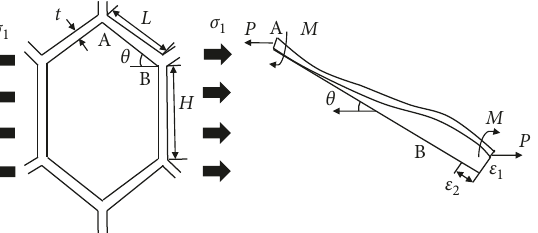
Figure 6: Horizontal deformation of honeycomb cell.